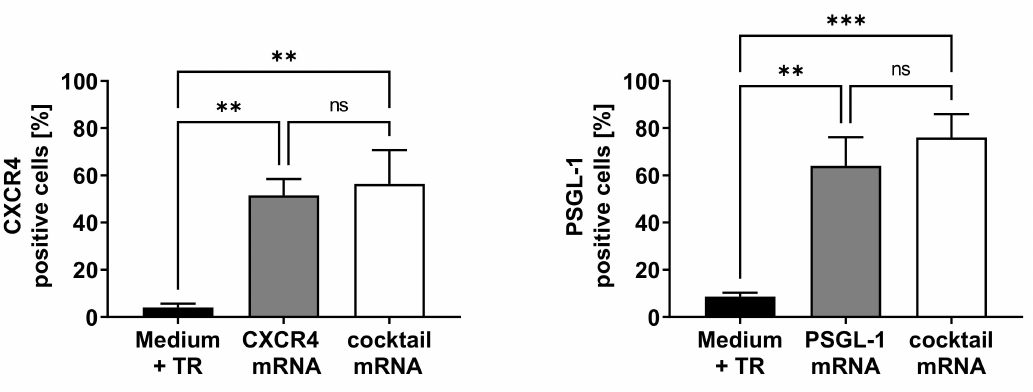
Figure 1. Analysis of CXCR4 and PSGL-1 expressions on the surfaces of EPCs after transfection with CXCR4 and PSGL-1 mRNA. A total of 1 × 10 5 EPCs were seeded and transfected after 24 h with either 1 µ g CXCR4, 1 µ g PSGL-1 mRNA, or both mRNAs (mRNA cocktail). The CXCR4 and PSGL-1 expressions on the cell surfaces were analyzed 24 h post-transfection using flow cytometry. Cells treated only with medium and transfection reagent (TR) were used as negative control. Results are shown as mean + SD ( n = 3). Statistical differences were determined using one-way ANOVA multiple comparisons, followed by Bonferroni’s multiple comparisons test (** p < 0.01 and *** p < 0.001; ns: nonsignificant).